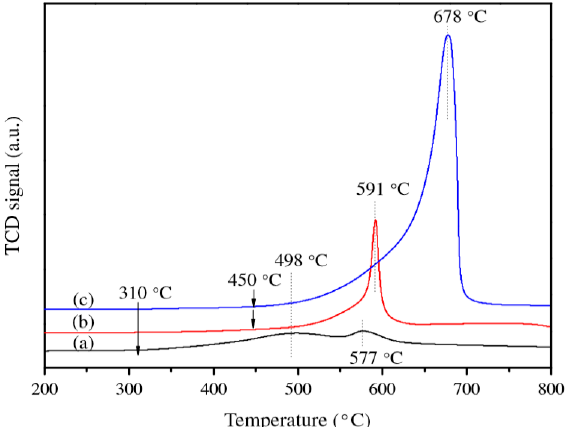
Figure 1. H 2 -TPR profiles of the catalysts: ( a ) CeTi (sol–gel method), ( b ) CeTi (impregnation method), ( c ) CeTi (coprecipitation method) [33,34].